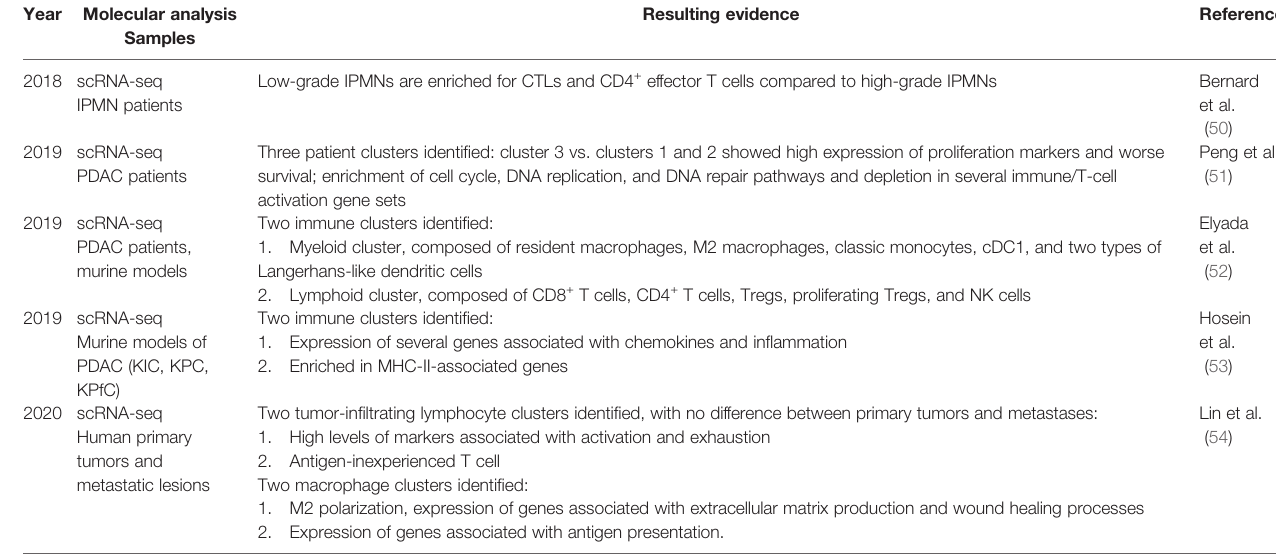
TABLE 1 | scRNA-seq analyses to dissect the molecular complexity of TME in PDAC: a historical